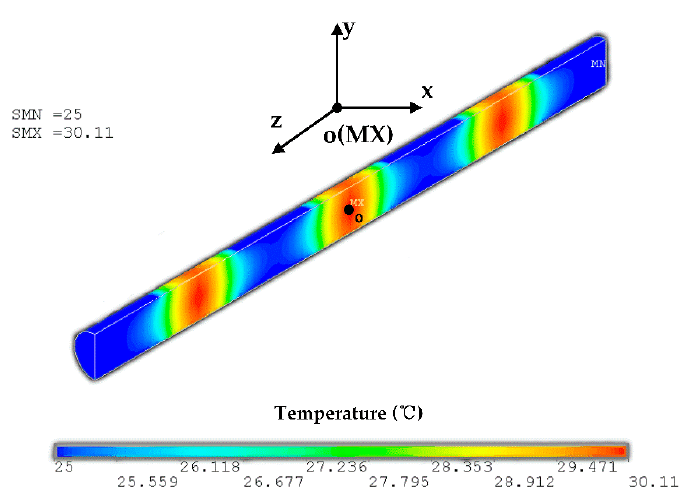
Figure 7. The temperature distribution of the laser rod with the segmented scheme.